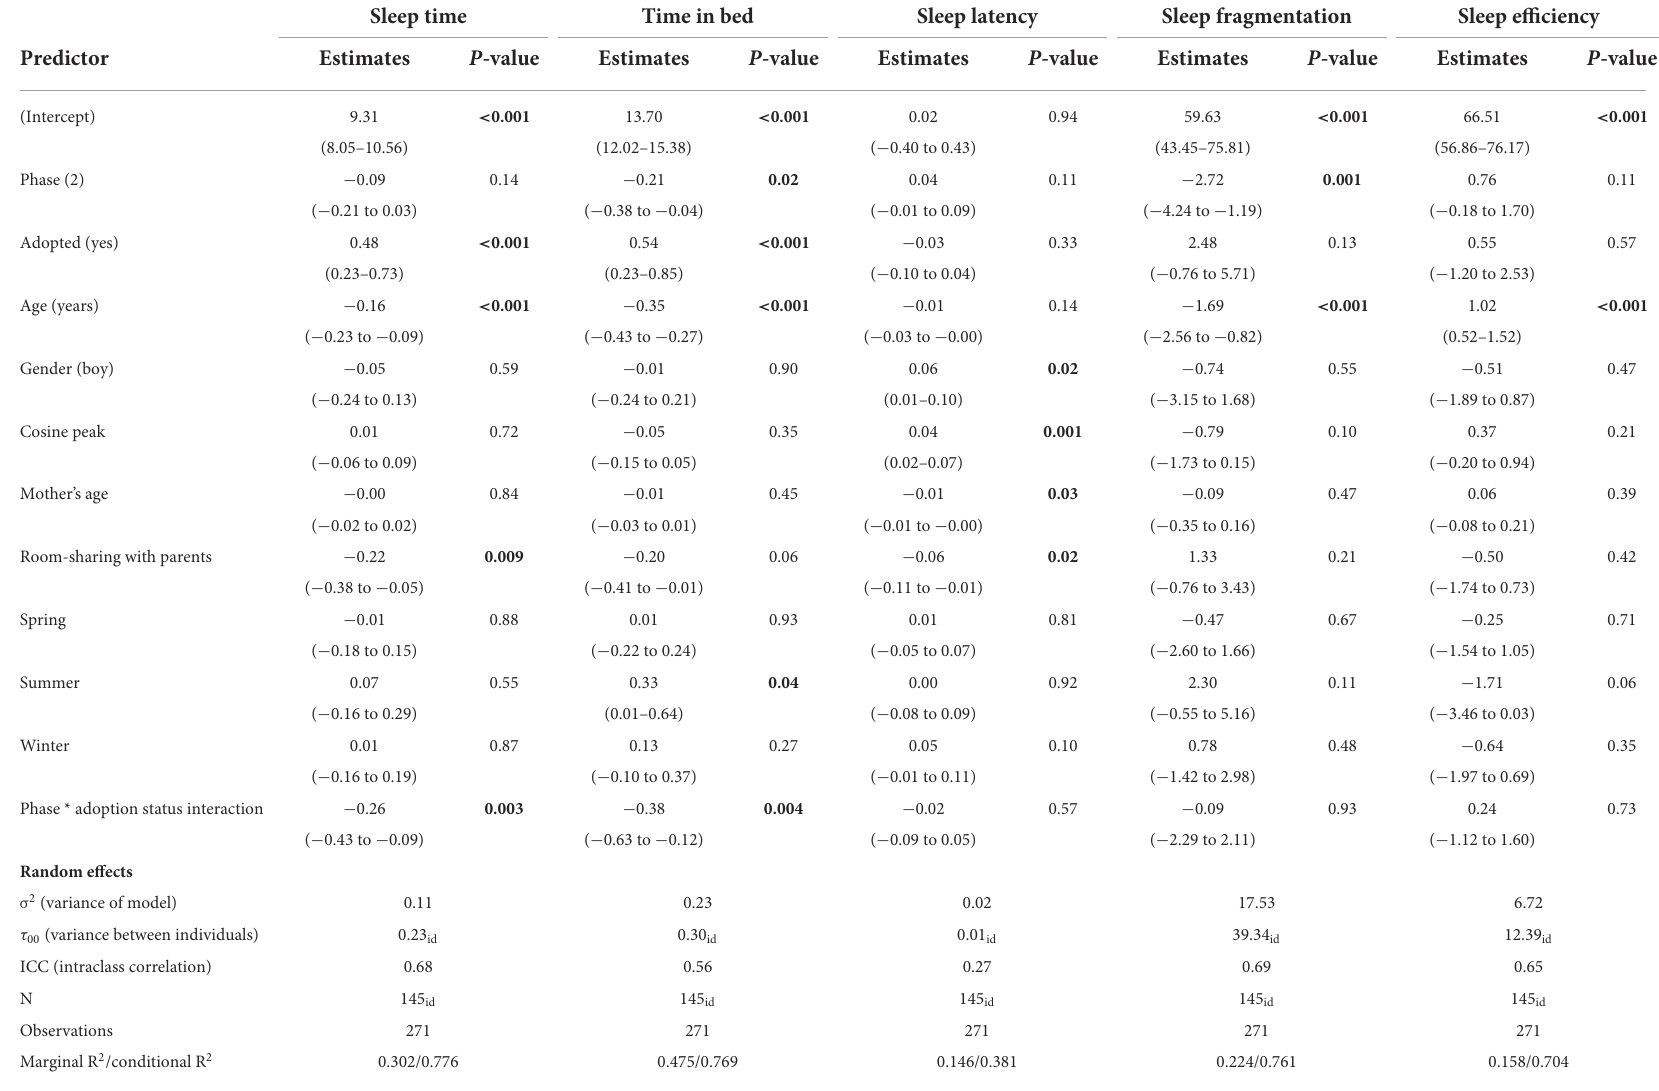
TABLE 2 Associations between adoption status and changes in total 24h sleep over the study